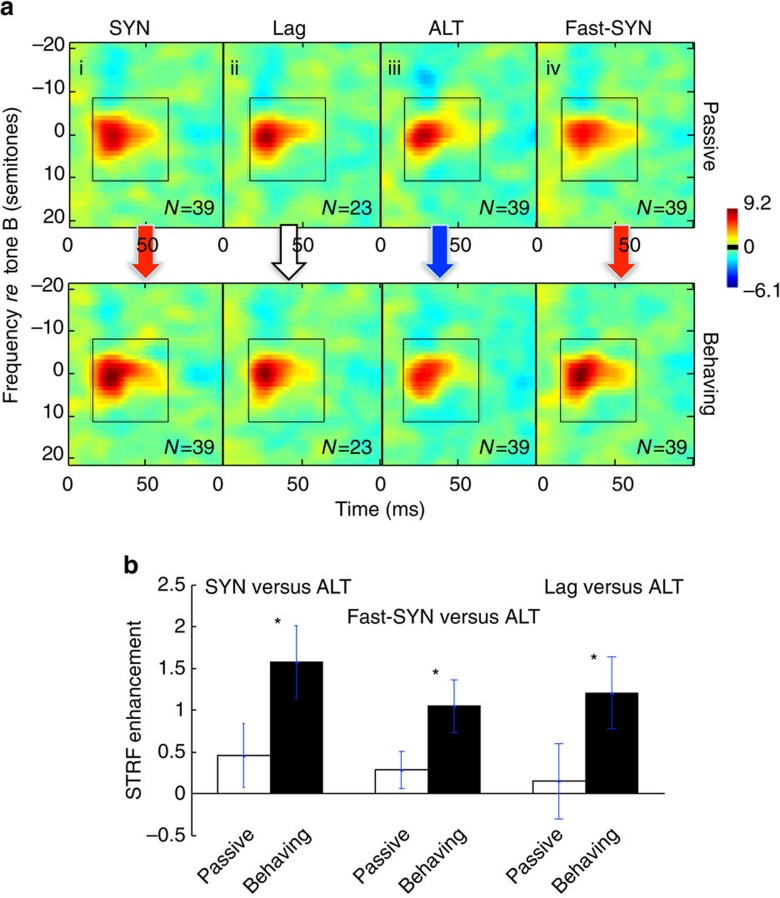
Effects of tone-sequence rates and time-lag averaged across cells.(a) Average STRF changes measured simultaneously in four different contexts. (i,iii) SYN and ALT are the usual contexts as depicted in Fig. 1; they exhibit the patterns of STRF enhancement in SYN during behaviour relative to the passive state (red arrow) and suppression in ALT (blue arrow); (ii) The time-Lag condition, where A tone sequences were lagged relative to B by 50% (40 ms). The coherence between the tones was therefore midway between that of SYN and ALT sequences, and the STRFs consequently exhibited little change (white arrow), a pattern similarly midway between the enhancement of the SYN and suppression of the ALT contexts; (iv) A Fast-SYN context in which the tone sequences repeated at twice the rate of the usual SYN condition. The STRF enhancement remained the same as in the SYN condition (red arrow). The two context tones were always separated by 12 semitones, and hence their responses were segregated. (b) Bar plots summarize the changes for SYN, Fast-SYN, and Lag contexts relative to the ALT condition, both in passive and behaviour conditions. All conditions led to large and significantly diverse effects, but only during behaviour (indicated by stars; SYN versus ALT: P<0.001; fast-SYN versus ALT: P<0.002; ALT and Lag contexts: P<0.010). Error bars indicate standard error.